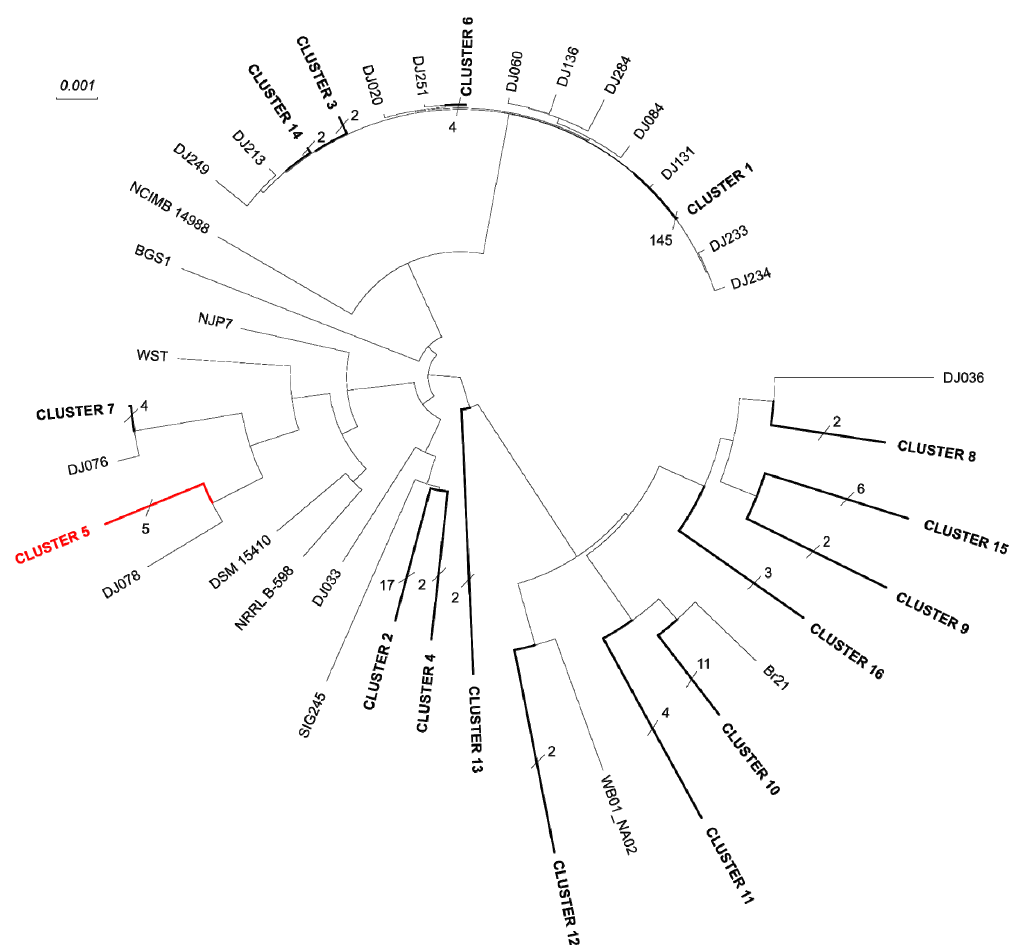
Figure 4. Phylogenetic reconstruction of Clostridium beijerinckii species. The phylogeny was reconstructed using 2308 genes of the core genome, present in every strain. Branches that were shorter than 1% of the maximum branch length were collapsed. The number of strains hidden under collapsed branches is written to each collapsed branch and strains are listed in Supplementary Table S9. The branch containing the type strain C. beijerinckii DSM 791 T is highlighted in red.